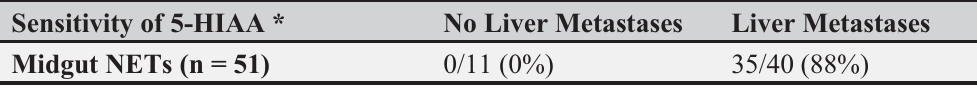
Table 6. Sensitivities of 5-HIAA (number of patients with median AP values above reference range/number of all patients of the corresponding group) depending on hepatic metastatic